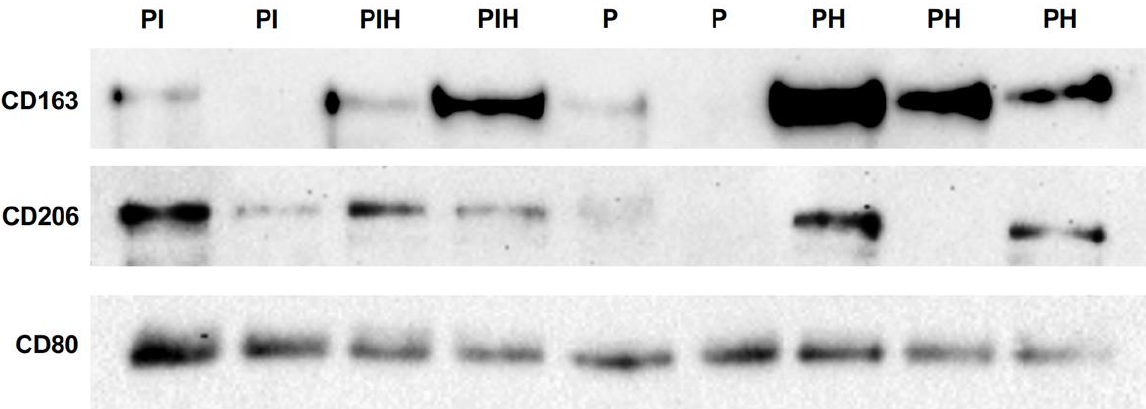
Figure 3. Representative immunoblot images of the analytes according to the groups. Reduced band intensities of CD163 in peri-implantitis and periodontitis lesions can be observed. PI, peri-implantitis; PIH, peri-implant health; P, periodontitis; PH, periodontal health. Table 1. Age, gender and site-specific clinical variables (probing depth (PPD), clinical attachment level (CAL) and bleeding on probing (BoP) values) according to groups.